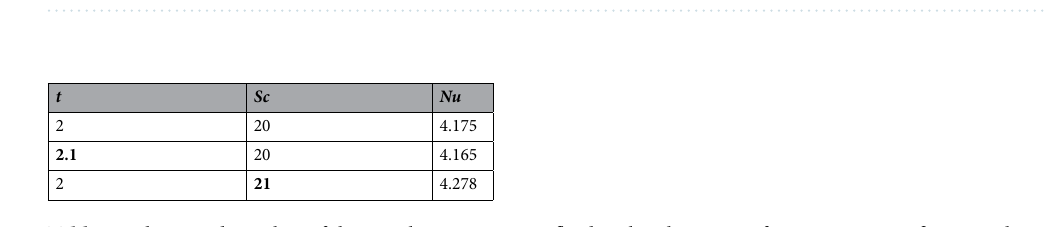
Table 3. Sherwood number of the couple stress Casson fluid at the plate y = 0 for α = 0.2 . Significance values are in